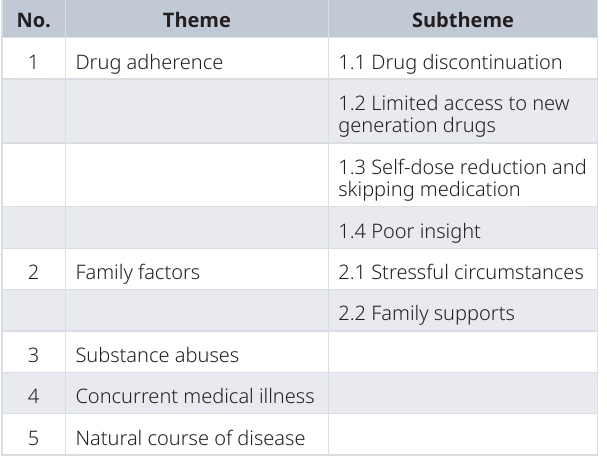
Table 2. Themes and subthemes constructed from the semi- structured interviews of the health professionals.